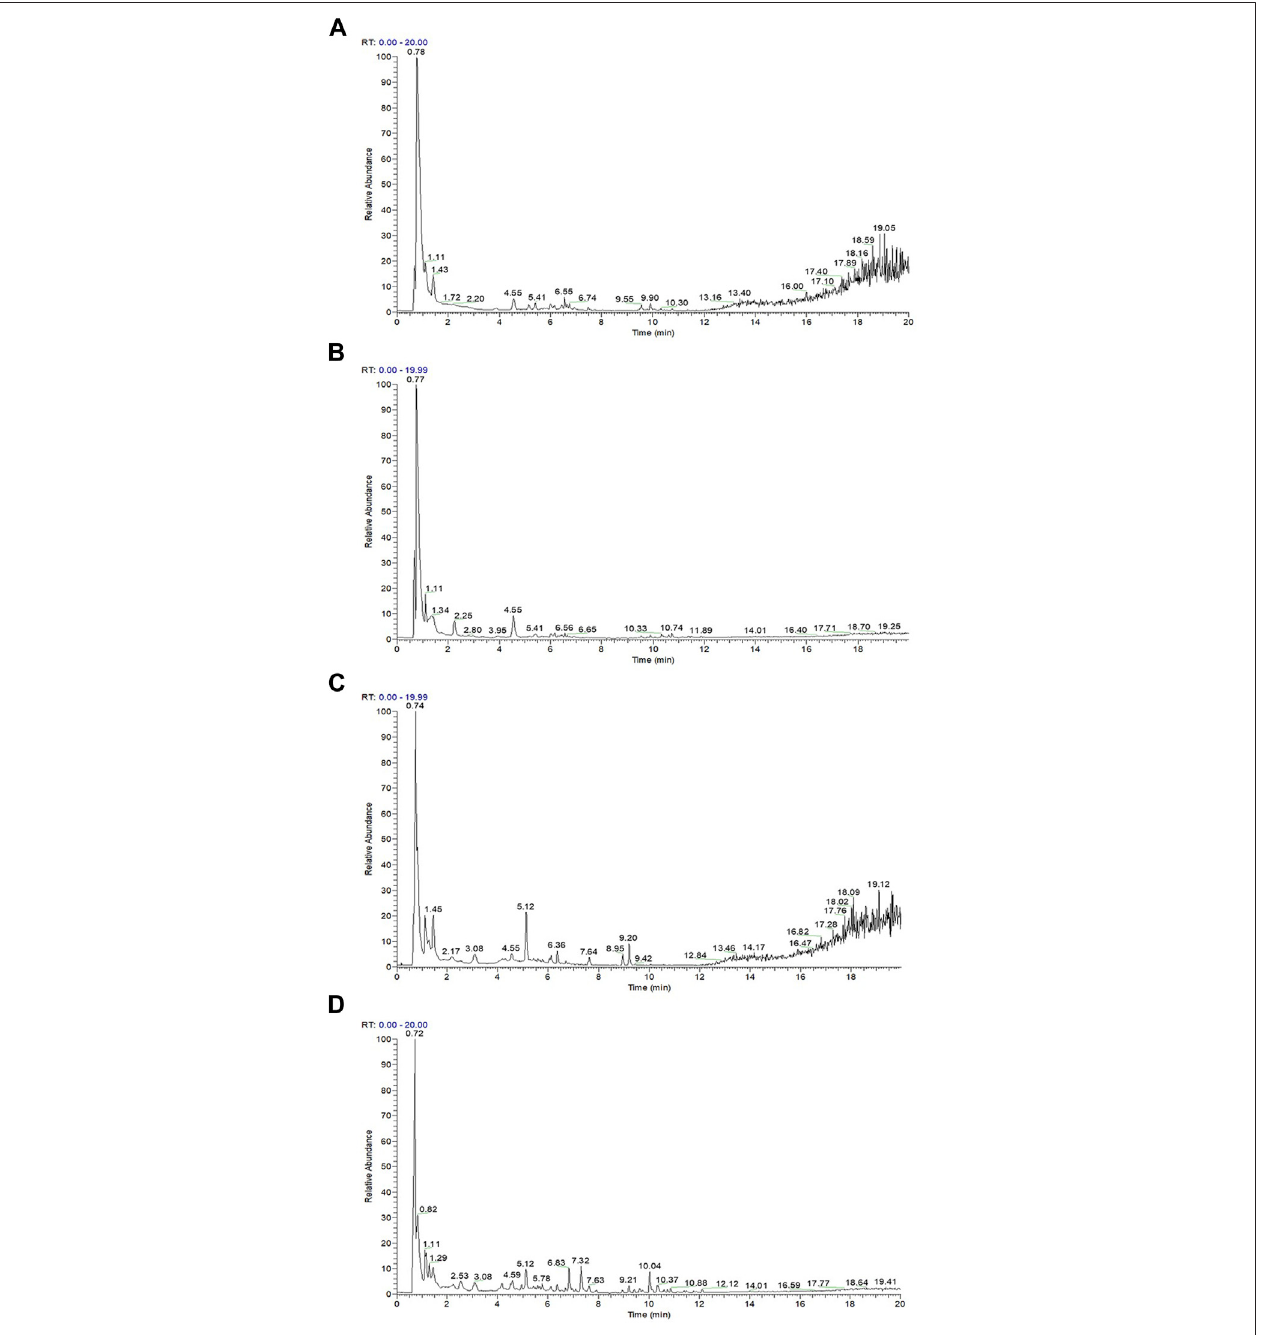
FIGURE 4 | Determination of positive and negative ion current patterns of sweet sorghum juice before and after extraction by liquid chromatography-mass spectrometry (A) isthepositiveion fl owdiagraminsweetsorghumjuicebeforeextraction (B) isthenegativeion fl owdiagraminsweetsorghumjuicebeforeextraction (C) is the positive ion fl ow diagram in the extracted sweet sorghum polyphenol extract (D) is the negative ion fl ow diagram in the extracted sweet sorghum polyphenol extract.